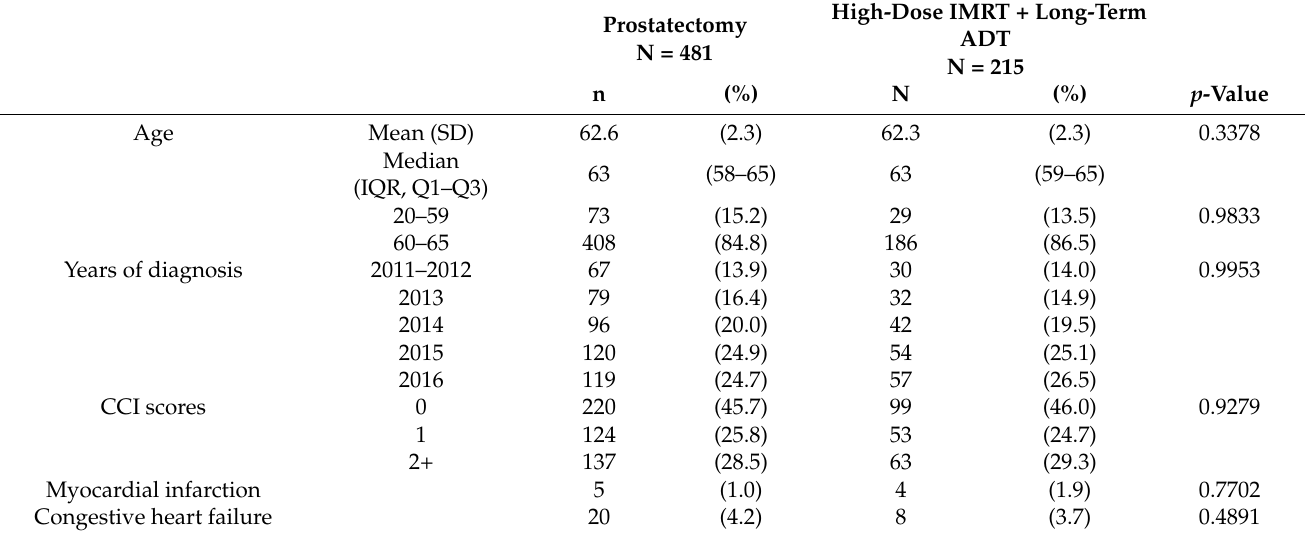
Table 1. Propensity score-matched demographic and clinic characteristics of young patients with high- to very high-risk prostate adenocarcinoma.